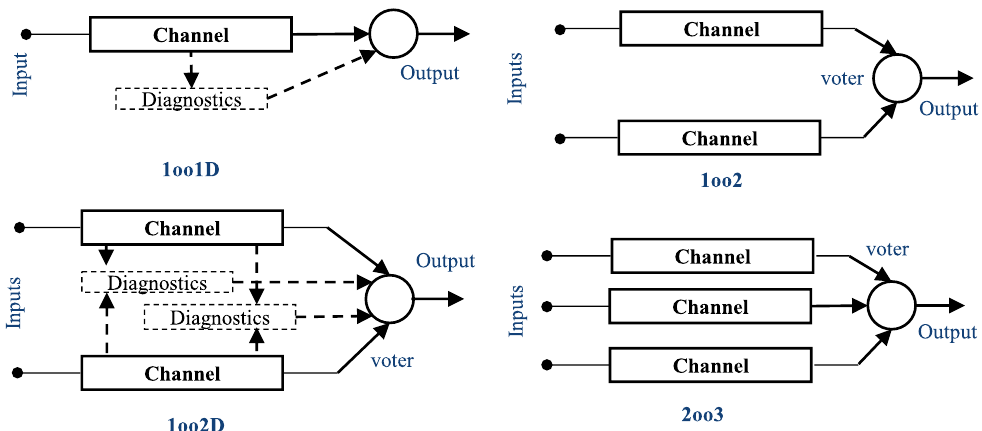
Figure 11. Different safety architectures describing the redundancy in a